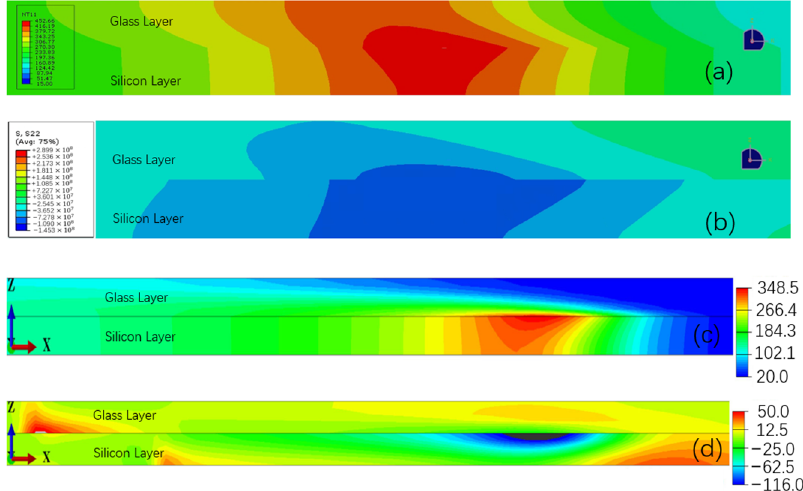
Figure 7. ( a ) Low speed temperature field distribution during steady expansion phase. ( b ) Distribu- tion of the low speed stress field in the stable expansion stage. ( c ) High speed temperature field distribution during the steady expansion phase. ( d ) Distribution of the high speed stress field in the stable expansion stage.